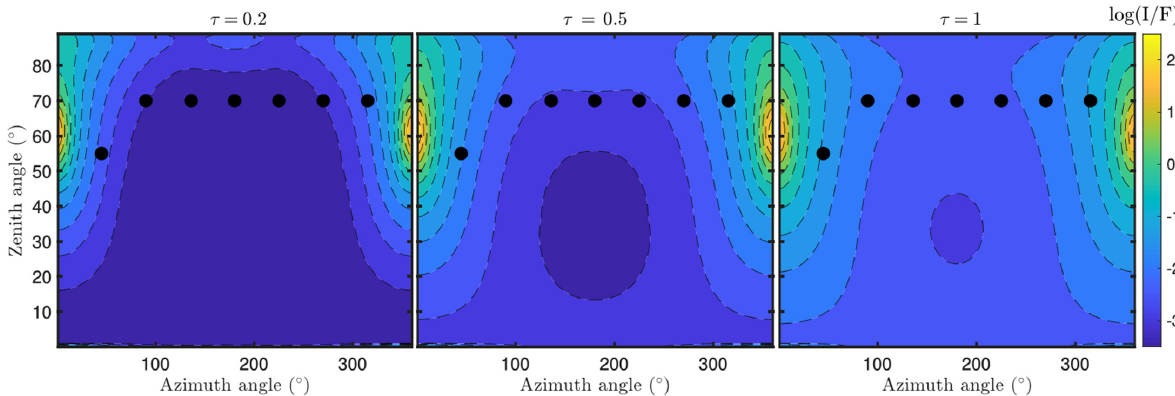
Figure 21. Variation of sky brightness with zenith and azimuth angles simulated for different values of dust opacity. Black dots indicate the angular positions of lateral RDS sensors. In addition to these observations, top channels will provide similar measurements but for a zenith angle ~ 0°.